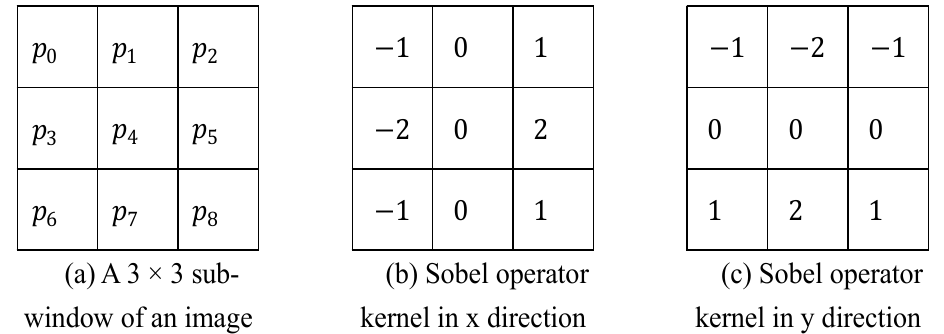
Figure 3. Sub-window of an image and Sobel operator kernel.